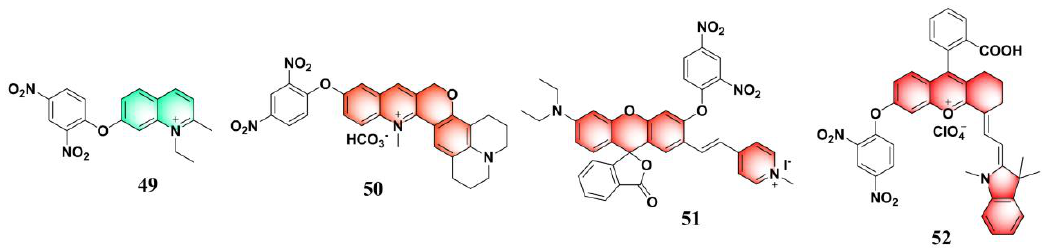
Figure 21. Fluorescent PhSH probes ( 49–52 ) based on positively charged fluorophores.